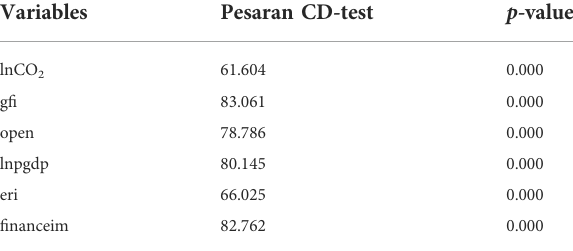
TABLE 2 Cross-sectional dependence test